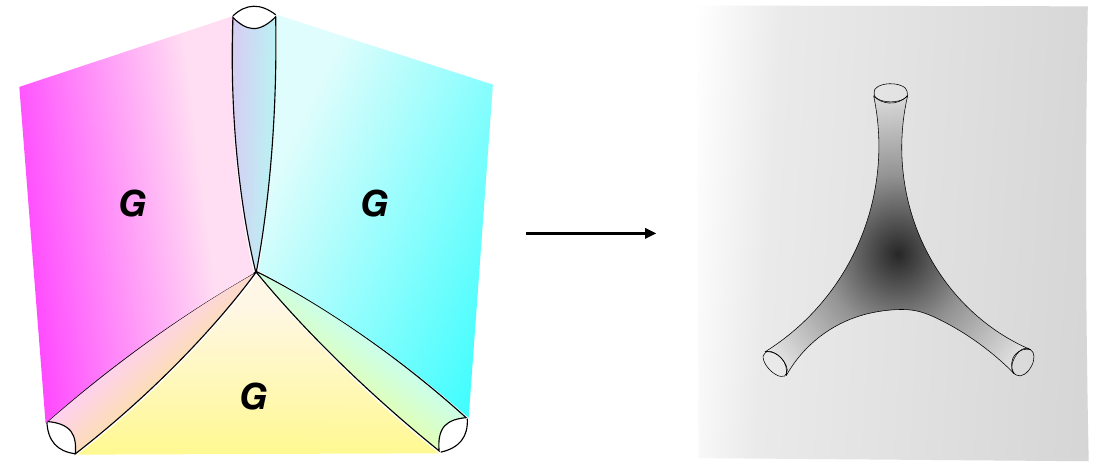
Figure 12 . On the left three non-compact surfaces with group G mutually meeting on cigar geometries, which intersect at a point. On the right the smoothing of the con(cid:12)guration to a single surface (grey) where only a subgroup H (cid:26) G may